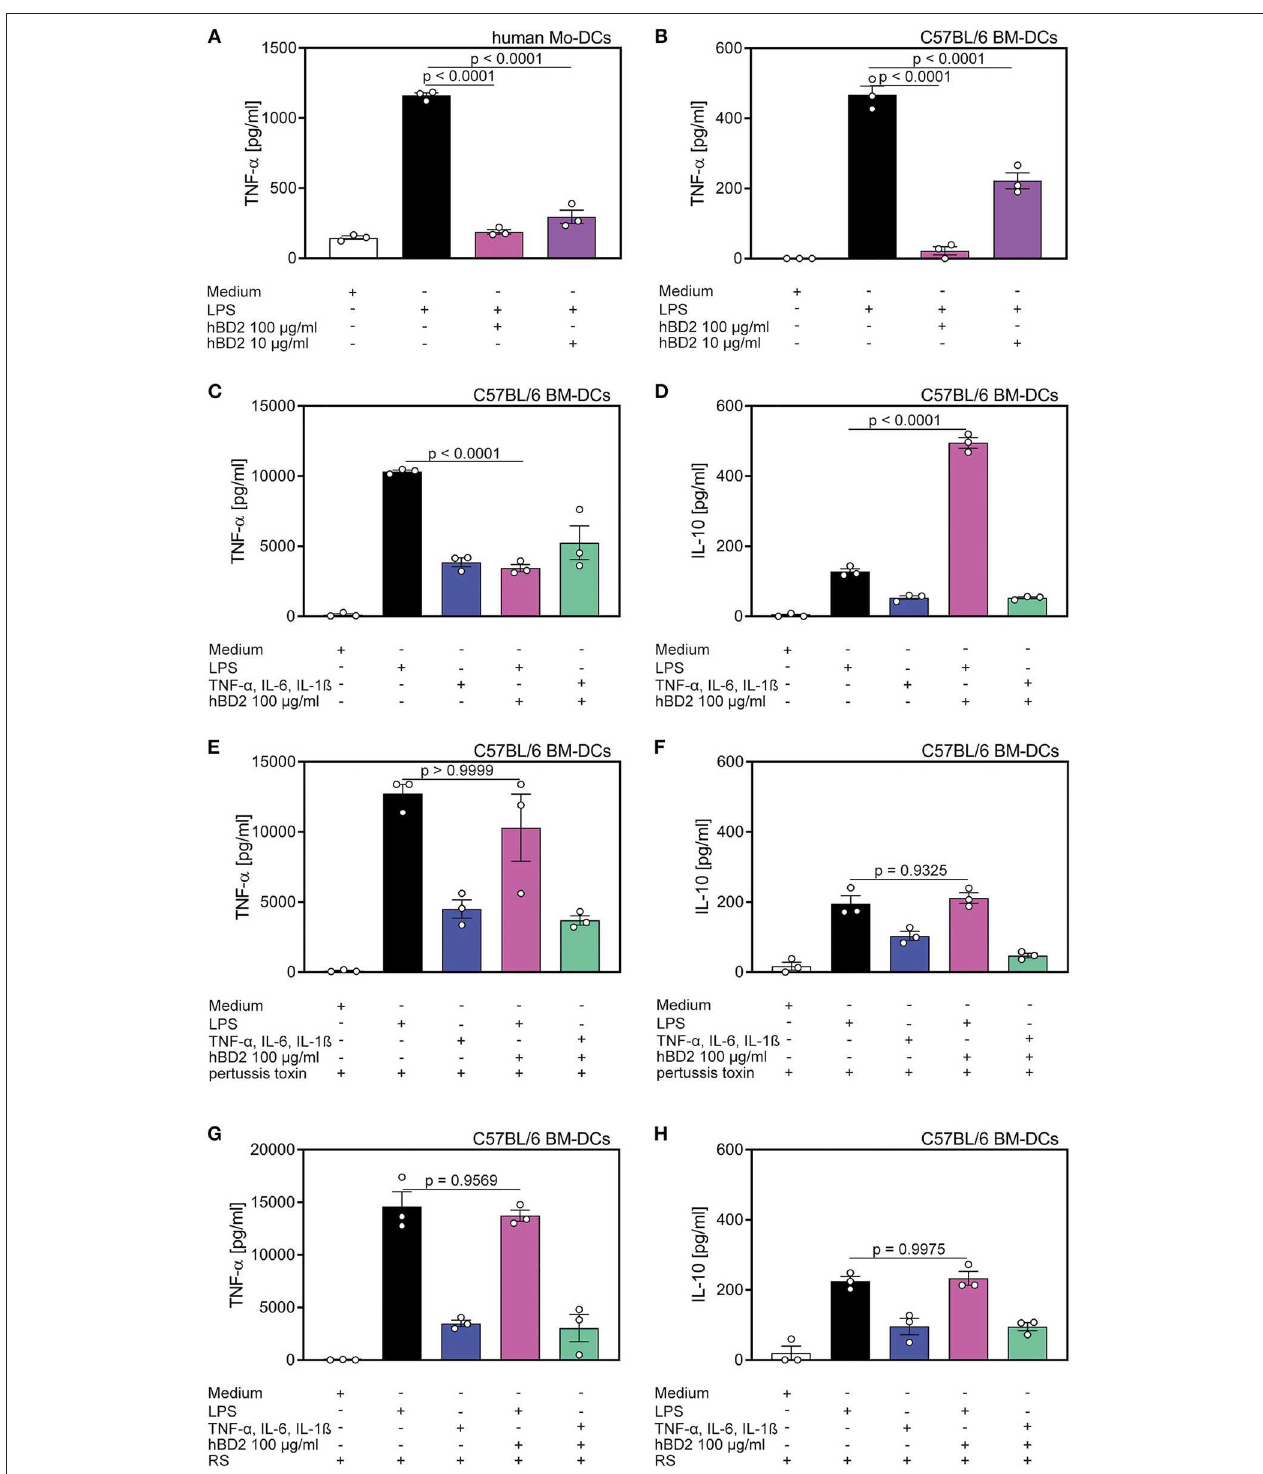
FIGURE 3 | Cytokine production of DC’s was affected by hBD2 in a TLR- and CCR2-dependent manner. Human mo-DC’s and murine BM-DC’s were treated with LPS (10 µ g/ml) alone or co-incubated with various concentrations of hBD2 (100 µ g/ml or 10 µ g/ml). Murine BM-DCs were additionally treated with pertussis toxin or the CCR2 inhibitor RS prior to stimulation with LPS or a cytokine cocktail containing TNF- α (0.2 mg/ml), IL-6 (0.2 mg/ml), and IL-1 β (0.2 mg/ml). Release of TNF- α in (A) human Mo-DC’s and in (B) murine BM-DC’s was quantified by ELISA. Release of TNF- α (C,E,G) and IL-10 (D,F,H) in murine BM-DCs was quantified by LEGENDplex. Results are presented as mean ± SEM, n = 3. Statistical test used is one-way ANOVA with Bonferroni post-test.